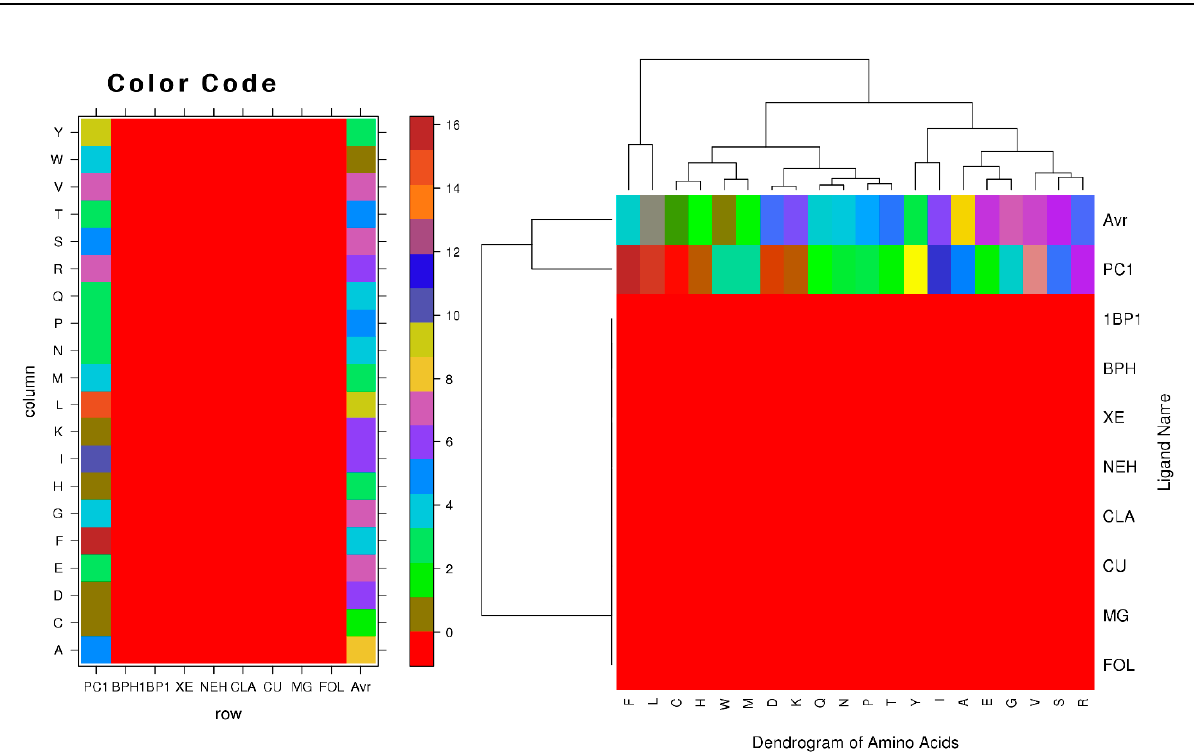
Figure 7. Clustering of amino acids according to the physical features of ligand-interacting amino acids ( right ) and the residue composition of various ligand binding sites ( left ). Table 7. Recognition of protein-ligand binding sites of BPIFA1 using complementary comparisons of binding-specific substructures and sequence profile alignment.